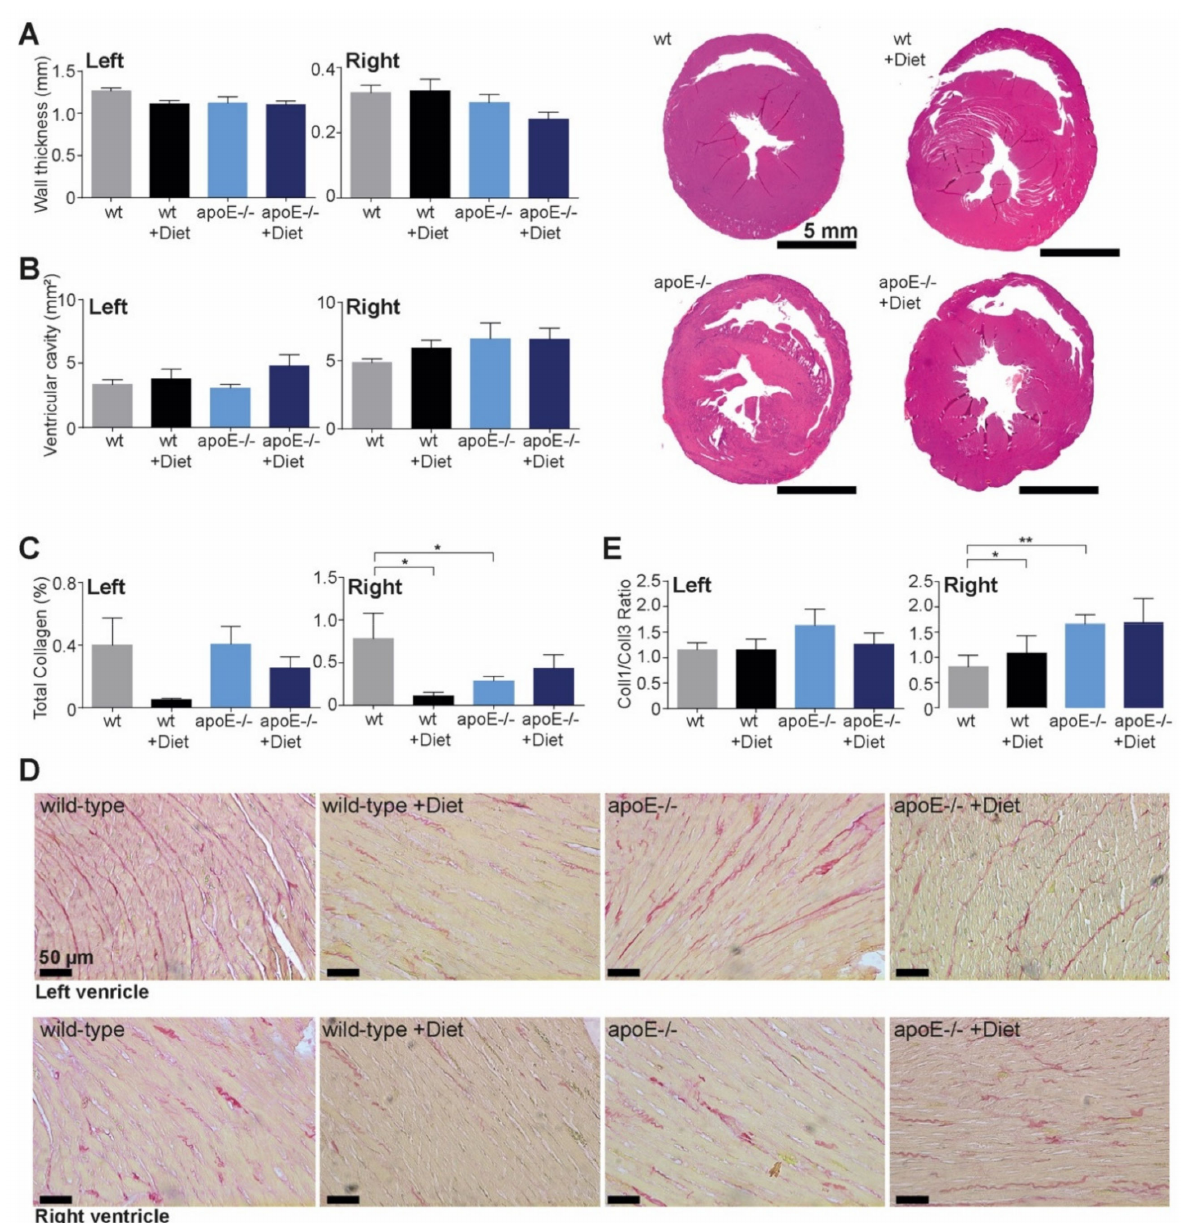
Figure 4. Histomorphometrical characterization of hearts in apoE − / − rats fed normal or high-fat diet ( A – D ). Twelve weeks (age 20 weeks) after feeding normal or high-fat diet, apoE − / − rats showed no differences in the heart dimensions compared with wild-type rats, while the right ventricle showed a decrease in collagen deposition and increased collagen1/collagen3 ratio in apoE − / − rats or rats fed high-fat diet. * p < 0.5, ** p < 0.01, n = 5–15, scale bar is indicated in the first image of each